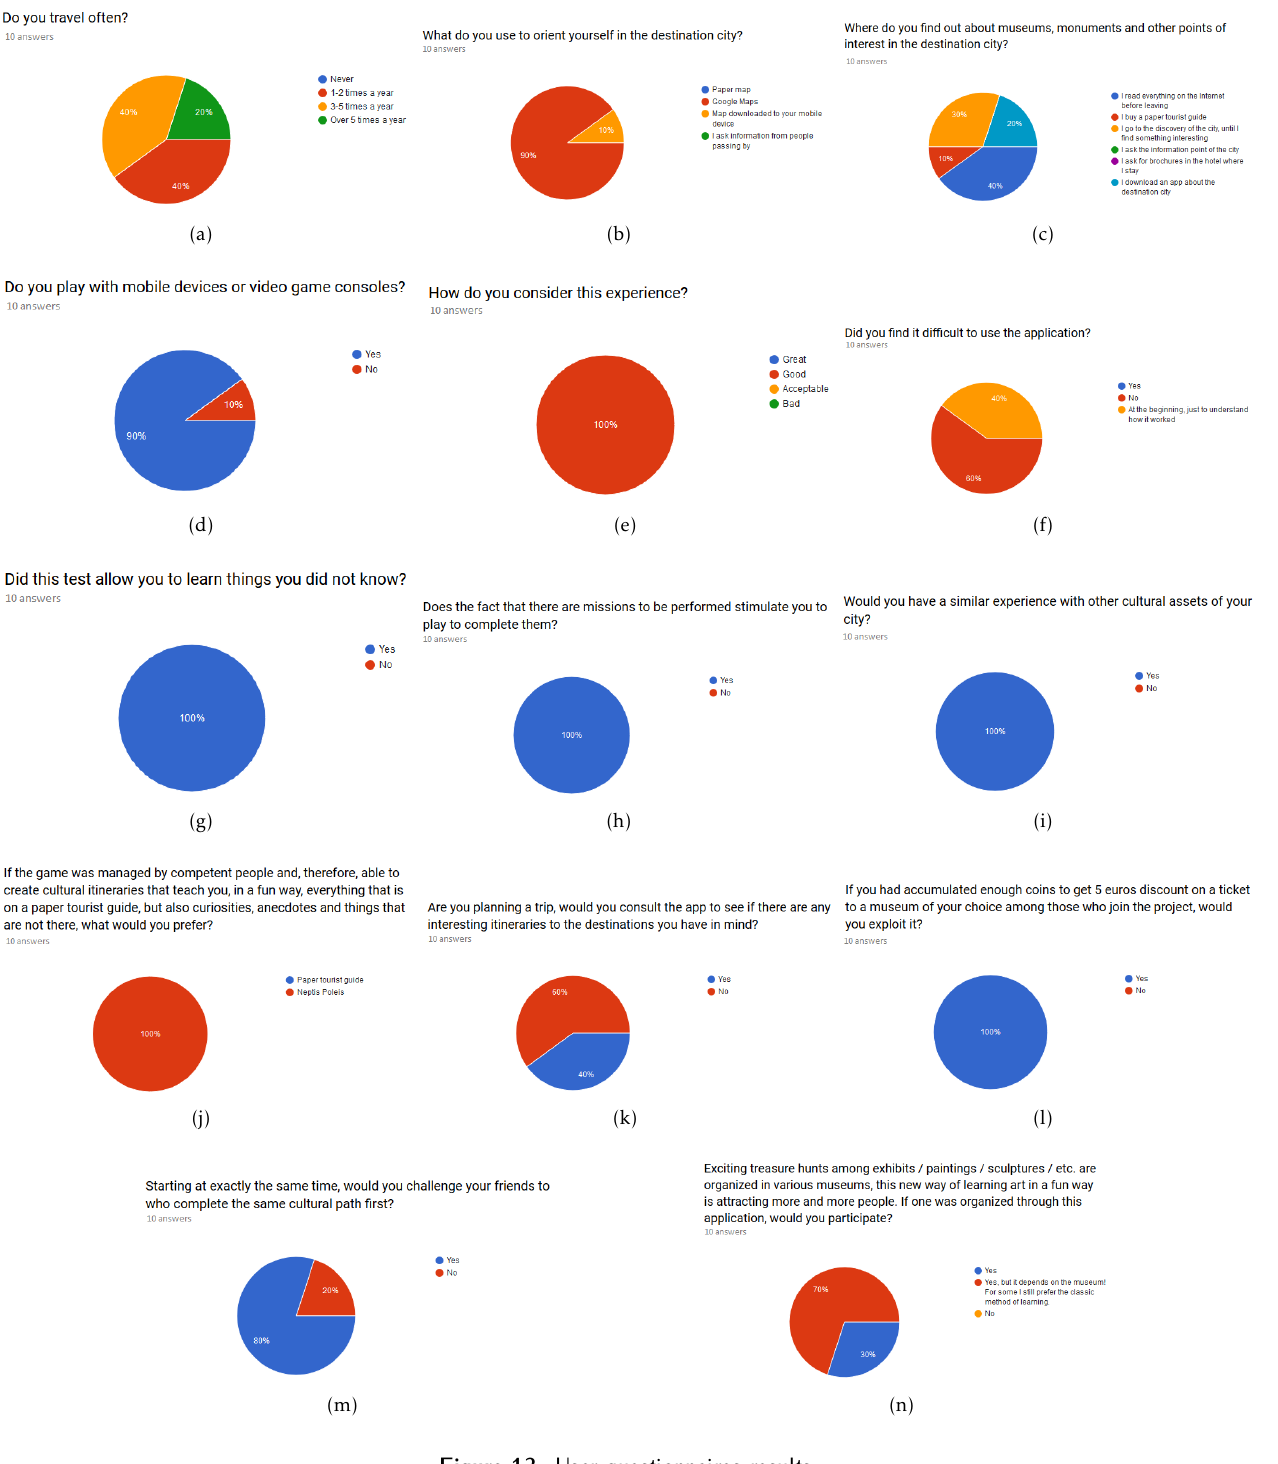
Figure 13. User questionnaires